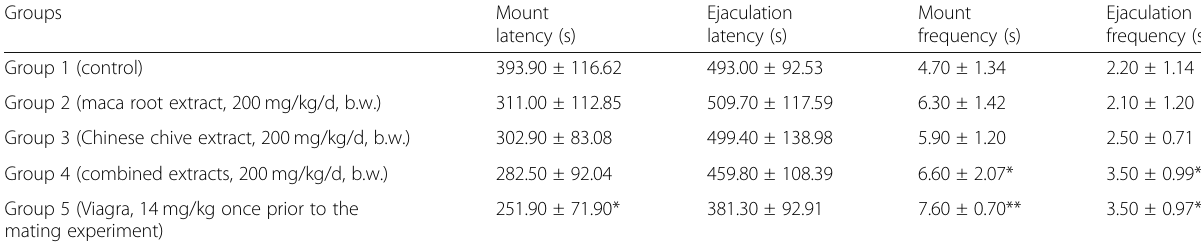
Table 1 Effects of maca extract, Chinese chive extract and combined extracts on sexual behaviour in mice (mean ± SD) Groups